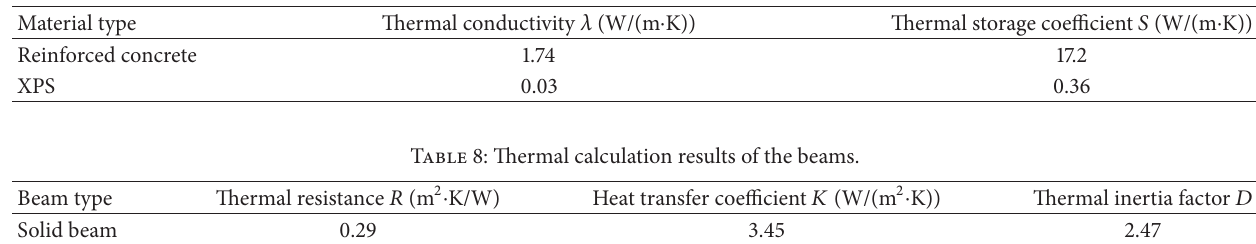
Table 7: Thermophysical parameters of the materials.